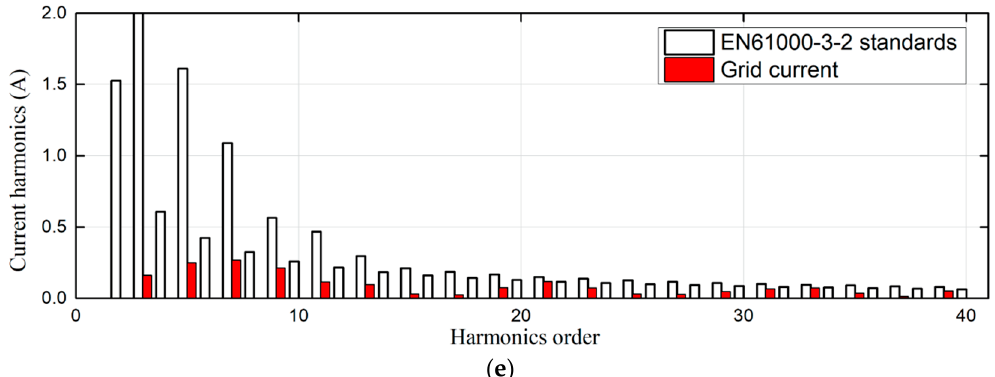
Figure 19. Simulation result of the FSMO estimate method with a PI controller: ( a ) Motor Speed; ( b ) Position and estimated error; ( c ) DC-link voltage and grid current; ( d ) Motor output torque; ( e ) FFT analysis of grid current.